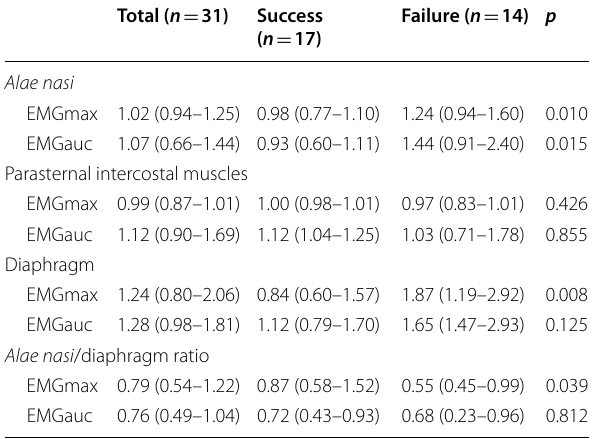
The EMG activity is described by peak EMG (EMGmax) and area under the curve (EMGauc). Values are normalized to EMG activity at initiation of the SBT and are expressed as the ratio of the EMG activity and the end of the SBT to the EMG activity at the initiation of the SBT Data are provided as median (interquartile